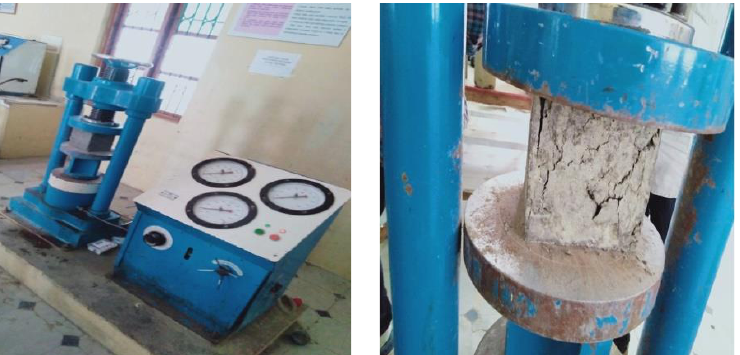
Figure 1. Compressive strength test.